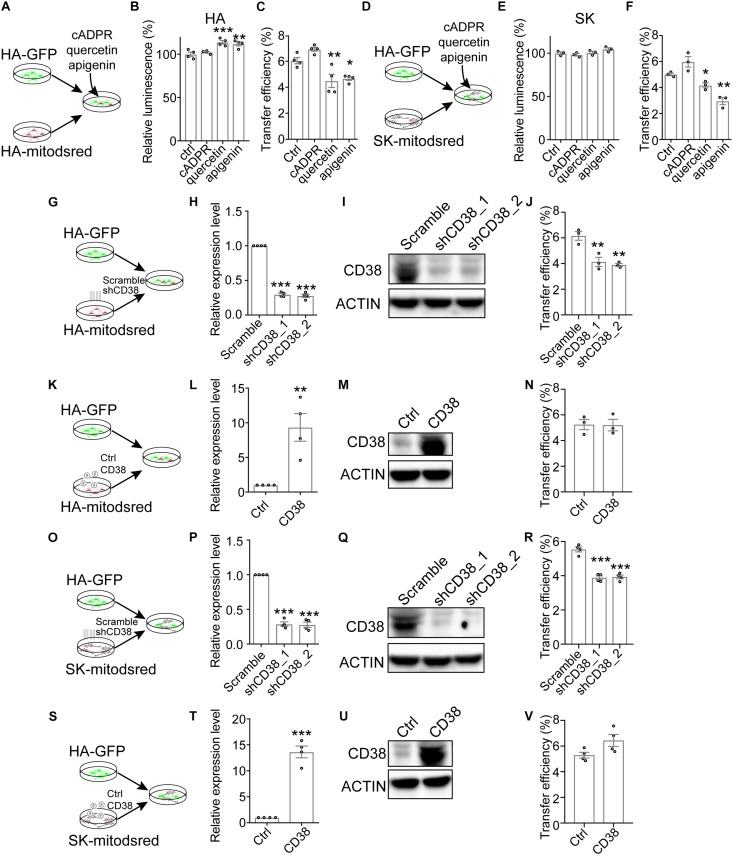
Contribution of CD38/cADPR signaling to the transfer (A–F). Effects of cADPR or CD38 inhibitors (quercetin, apigenin) on mitochondrial transfer between neural cells. (A) Schematic showing that co-cultured HA-GFP and HA-mitodsred cells were treated with cADPR, quercetin, or apigenin. (B) Analysis of cell viability on HA with indicated treatment for 24 h by CellTiter Glo. (Adjusted p values: ctrl vs. cADPR, 0.7403; ctrl vs. quercetin, 0.0009; and ctrl vs. apigenin, 0.0029). (C) Flow cytometry analyzing mitochondrial transfer efficiency between HA with indicated chemical treatment for 24 h. (Adjusted p values: ctrl vs. cADPR, 0.1478; ctrl vs. quercetin, 0.0091; and ctrl vs. apigenin, 0.0194). (D) Schematic showing that co-cultured HA-GFP and SK-mitodsred cells were treated with cADPR, quercetin, or apigenin. (E) Analysis of cell viability on SK with indicated treatment for 24 h by CellTiter Glo. (Adjusted p values: ctrl vs. cADPR, 0.7573; ctrl vs. quercetin, 0.9783; and ctrl vs. apigenin, 0.1579). (F) Flow cytometry analyzing mitochondrial transfer efficiency from SK into HA with indicated chemical treatment for 24 h. (Adjusted p values: ctrl vs. cADPR, 0.0775; ctrl vs. quercetin, 0.01263; and ctrl vs. apigenin, 0.0015). (G–N) Effects of CD38 in HA-mitodsred on mitochondrial transfer between HA. (G) Schematic showing that HA-GFP were co-cultured with indicated HA-mitodsred. (H,I). RT-qPCR (H) and western blot (I) analysis of CD38 expression on HA-mitodsred with indicated shRNA transduction. (Adjusted p values in H: Scramble vs. shCD38_1, <0.001; Scramble vs. shCD38_2, <0.001). (J) Flow cytometry analyzing mitochondrial transfer efficiency from indicated HA-mitodsred into HA-GFP after co-cultured for 24 h. (Adjusted p values: Scramble vs. shCD38_1, 0.0048; Scramble vs. shCD38_2, 0.0027). (K) Schematic showing that HA-GFP were co-cultured with indicated HA-mitodsred. (L,M) RT-qPCR (L) and western blot (M) analysis of CD38 expression on HA-mitodsred with indicated lentiviral infection. (p = 0.0059 in M). (N) Flow cytometry analyzing mitochondrial transfer efficiency from indicated HA-mitodsred into HA-GFP after co-cultured for 24 h. (p = 0.9483). (O–V) Effects of CD38 in SK-mitodsred on mitochondrial transfer from SK into HA. (O) Schematic showing that HA-GFP were co-cultured with indicated SK-mitodsred. (P,Q) RT-qPCR (P) and western blot (Q) analysis of CD38 expression on SK-mitodsred with indicated shRNA transduction. (Adjusted p values in P: Scramble vs. shCD38_1, <0.001; Scramble vs. shCD38_2, <0.001). (R) Flow cytometry analyzing mitochondrial transfer efficiency from indicated SK-mitodsred into HA-GFP after co-cultured for 24 h. (Adjusted p values: Scramble vs. shCD38_1, p < 0.001; Scramble vs. shCD38_2, p < 0.001). (S) Schematic showing that HA-GFP were co-cultured with indicated SK-mitodsred. (T,U) RT-qPCR (T) and western blot (U) analysis of CD38 expression on SK-mitodsred with indicated lentiviral infection. (p < 0.001) (V) Flow cytometry analyzing mitochondrial transfer efficiency from indicated SK-mitodsred into HA-GFP after co-cultured for 24 h. (p = 0.0697) Data are represented as mean ± SEM. One-way ANOVA followed Dunnett’s multiple comparisons test was applied in B,
C,
E,
F,
H,
J,
P,
R; Two-tailed student t test was used in L,
N,
T,
V. *p < 0.05, ∗∗p < 0.01, and ∗∗∗p < 0.001.